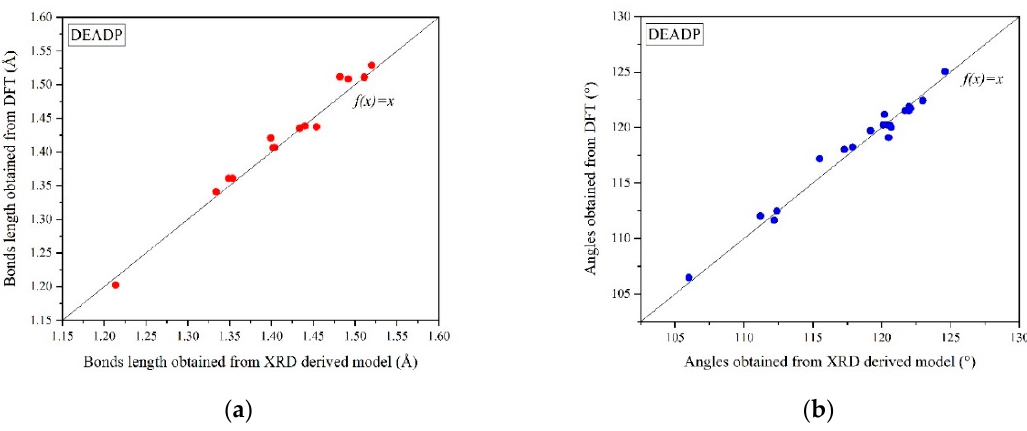
Figure 10. Comparison between the ( a ) bond lengths and ( b ) angles obtained using DFT method (M06-2X) and experimental result for DEADP molecule.